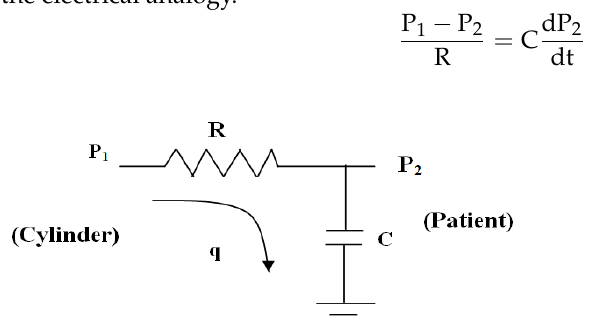
Figure 3. Oxygen cylinder model with input–output.